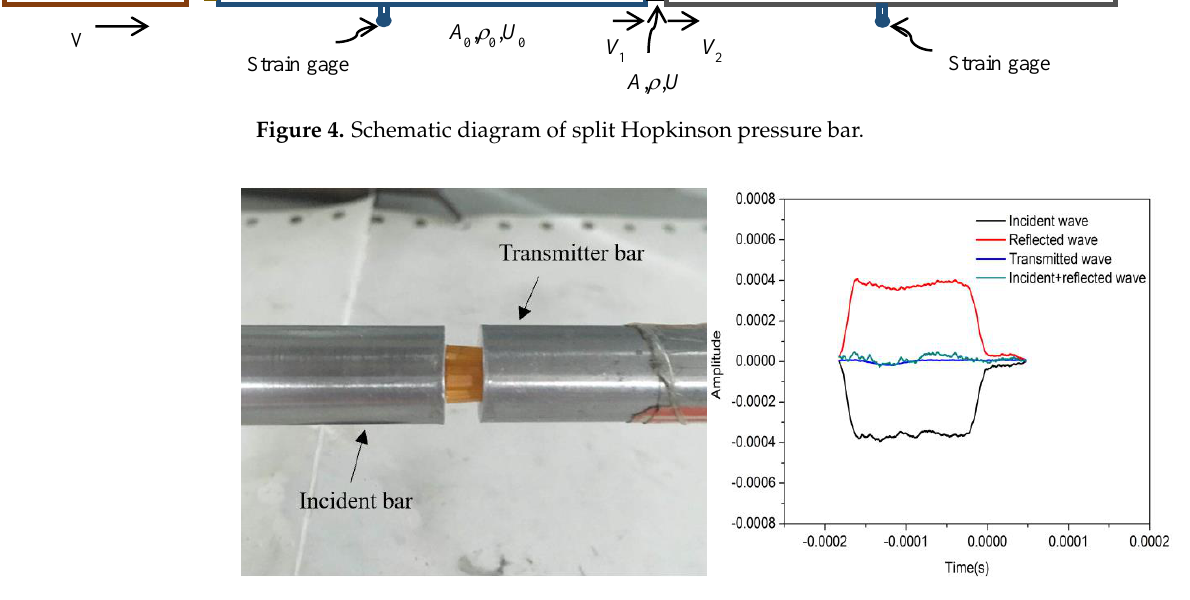
Figure 4. Schematic diagram of split Hopkinson pressure bar. Figure 5. Experimental process and pulse signal by SHPB. Figure 5. Experimental process and pulse signal by